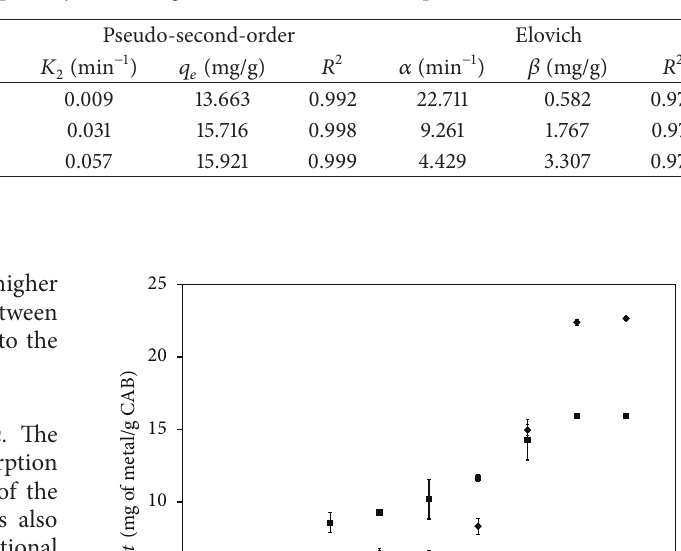
Table 2: Kinetic parameters of lead sorption by calcium alginate beads at different temperatures.